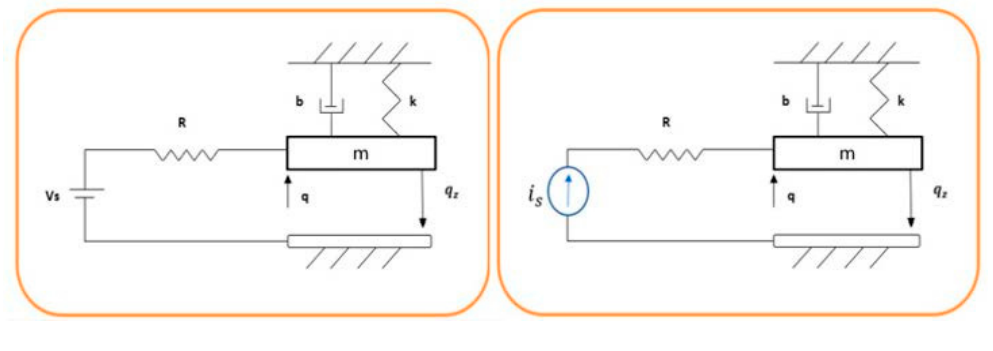
Figure 1. Scheme of 1-DOF parallel-plate electrostatic actuator.